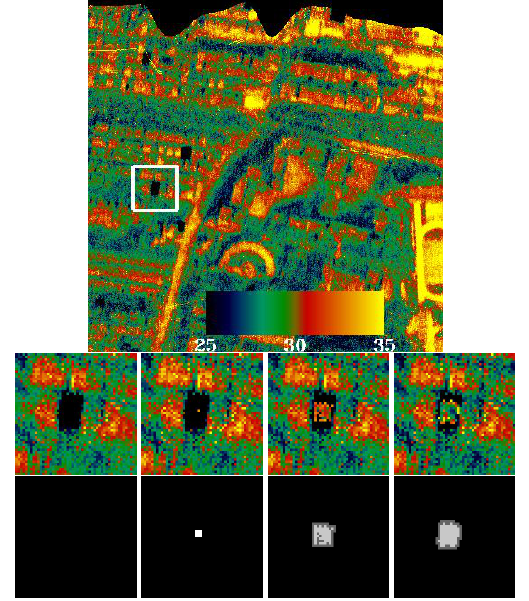
Figure 5. Top: Taipei subset temperature; middle: zoom for thc=0.70, 0.75, 0.80, 0.85; bottom: masks.